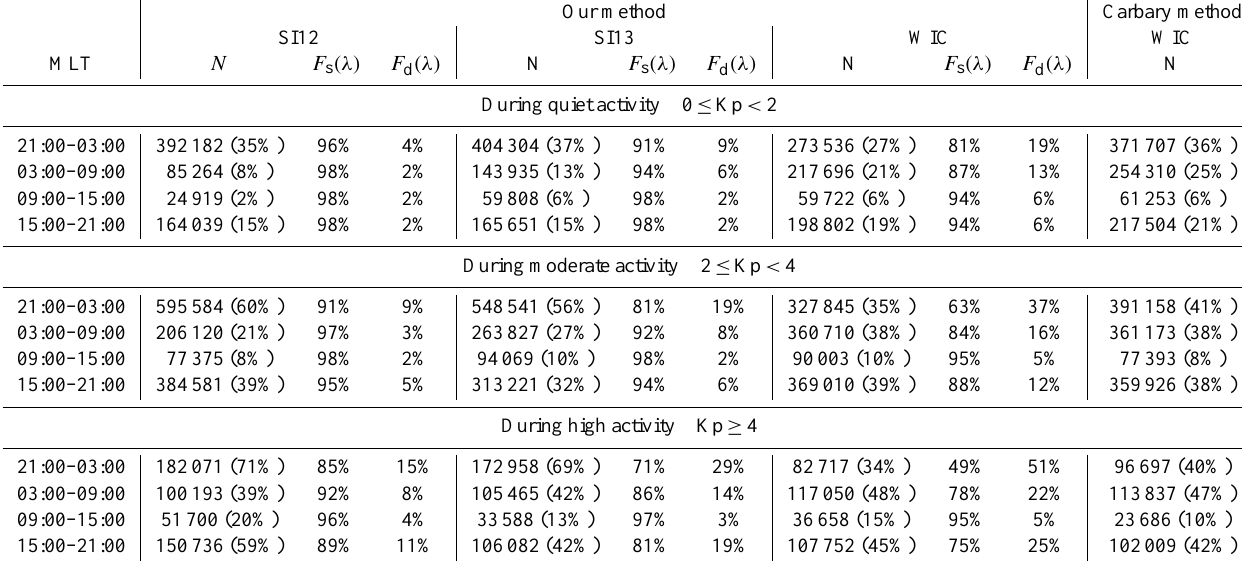
Fig. 4. Number of PALBs in each MLT sector derived from IMAGE FUV WIC images (red line), SI12 images (blue line), and SI13 images (green line) from May 2000 until August 2002 using the technique outlined in this paper (panel a ). Panel (b) shows the percentage of these successful boundary locations that are derived from fits of the function F d (λ) to latitudinal intensity profiles. Table 1. Number ( N ) of PALB estimations derived from IMAGE FUV images between May 2000 and August 2002 using the method outlined in this paper (all three FUV detectors) and the method of Carbary et al. (2003) (WIC images only) separated by MLT and geomag- netic activity. The percentages of successfully located PALBs out of the total available luminosity profiles are shown in parentheses. The percentages of successfully located PALBs made from single Gaussian fits ( F s (λ) ) and double Gaussian fits ( F d (λ) ) are also shown. Our method Carbary